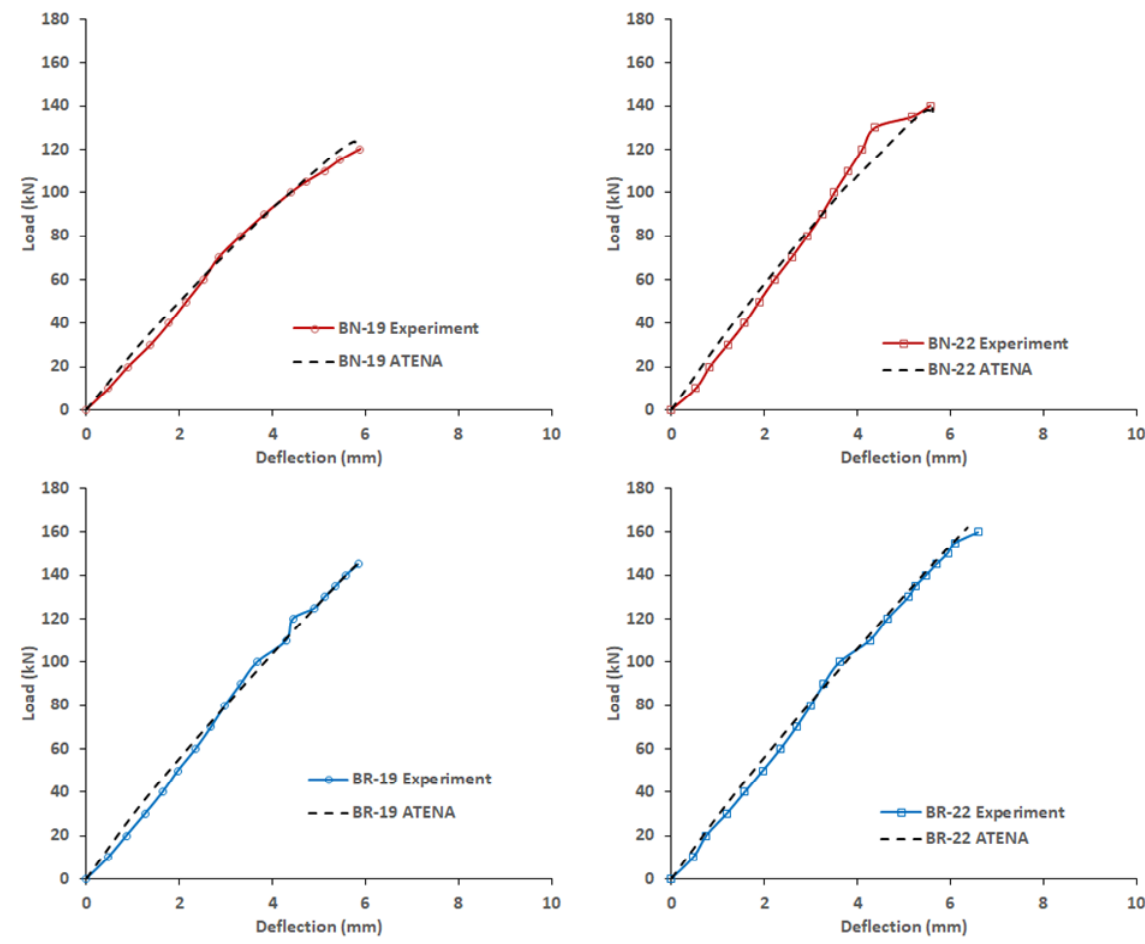
Figure 6. Experimental vs. numerical load-deflection.